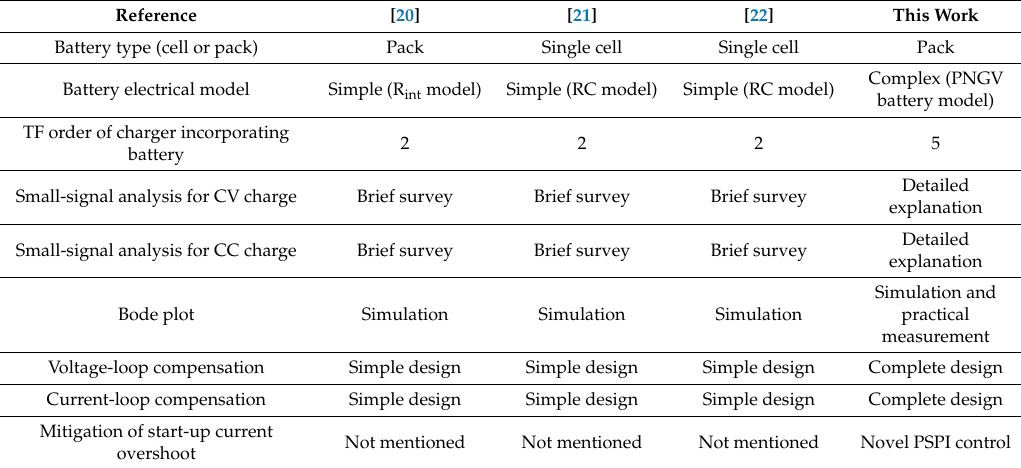
Table 2. Comparisons of charger technologies and control methods.